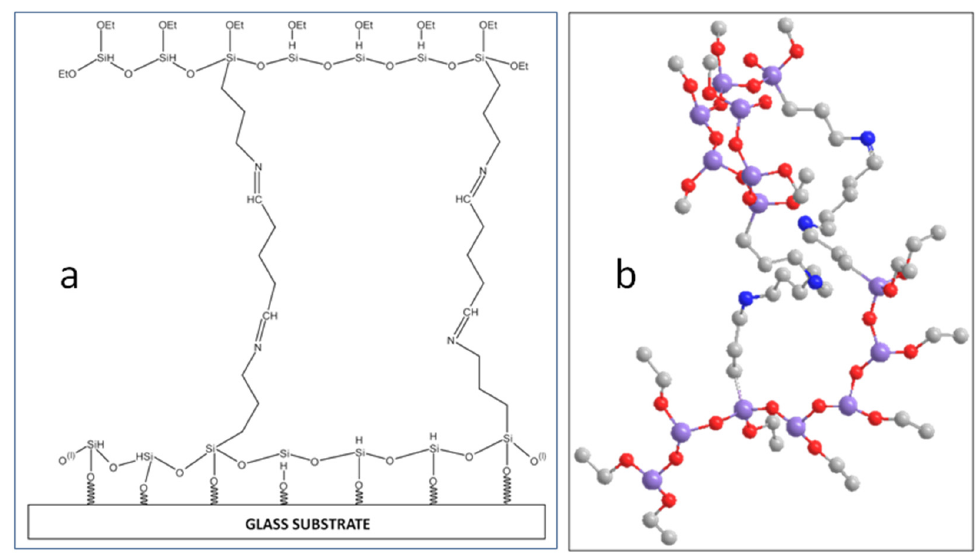
Figure 1. Chemical reaction of 3-aminopropyltriethoxysilane (AP) and Glutaraldehyde (GA) layered on a glass substrate ( a ); 3D view of AP/GA network; purple: silicon atoms (-Si-); reds: oxygen atoms (-O-); gray: carbon atoms (-C-); blue: nitrogen atoms (-N-) ( b ).